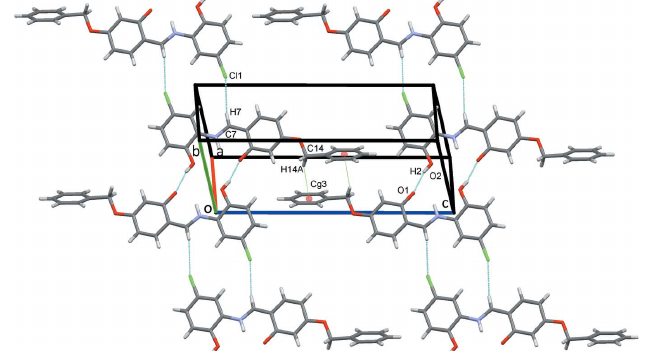
Figure 6 Sheets of molecules of (II) parallel to (120).